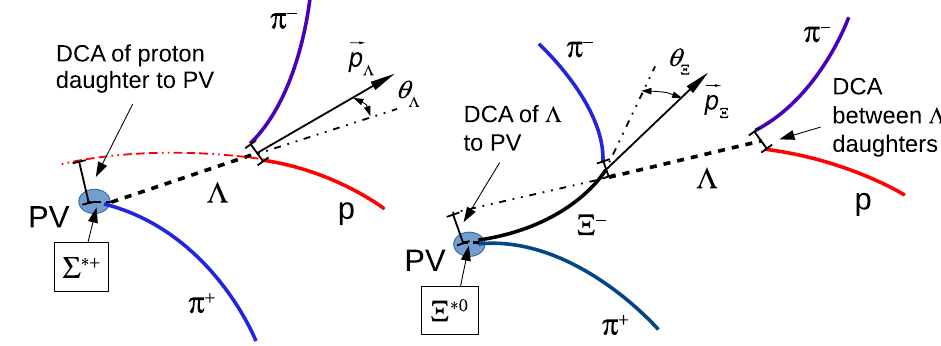
Fig. 1 Sketch of the decay modes for (cid:3) ∗+ ( left ) and (cid:4) ∗ 0 ( right ) and depiction of the track and topological selection